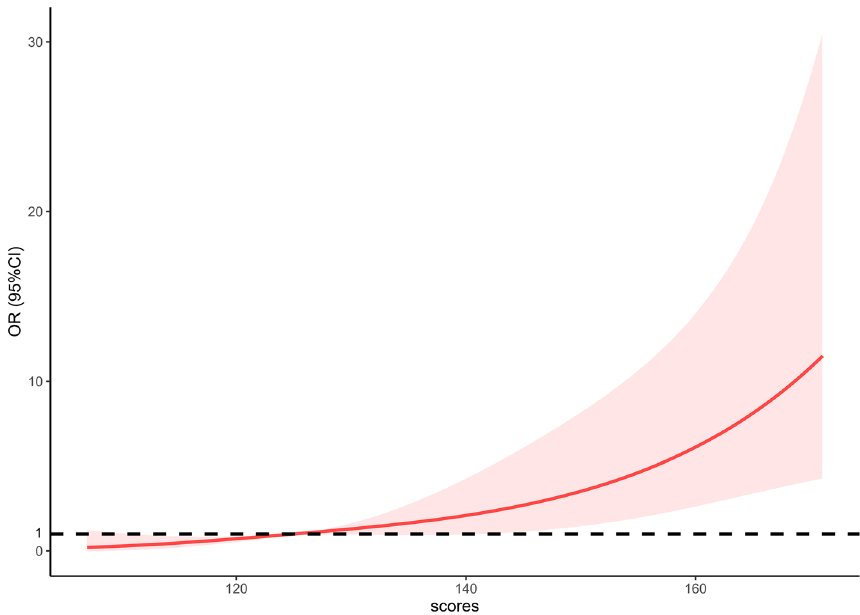
Figure 6. Restricted cubic splines for the nonlinear relationship between the risk of twin preterm birth < 32 weeks and increased risk scores. The solid line displays the odds ratio (OR), and the dashed line represents the 95% confidence interval